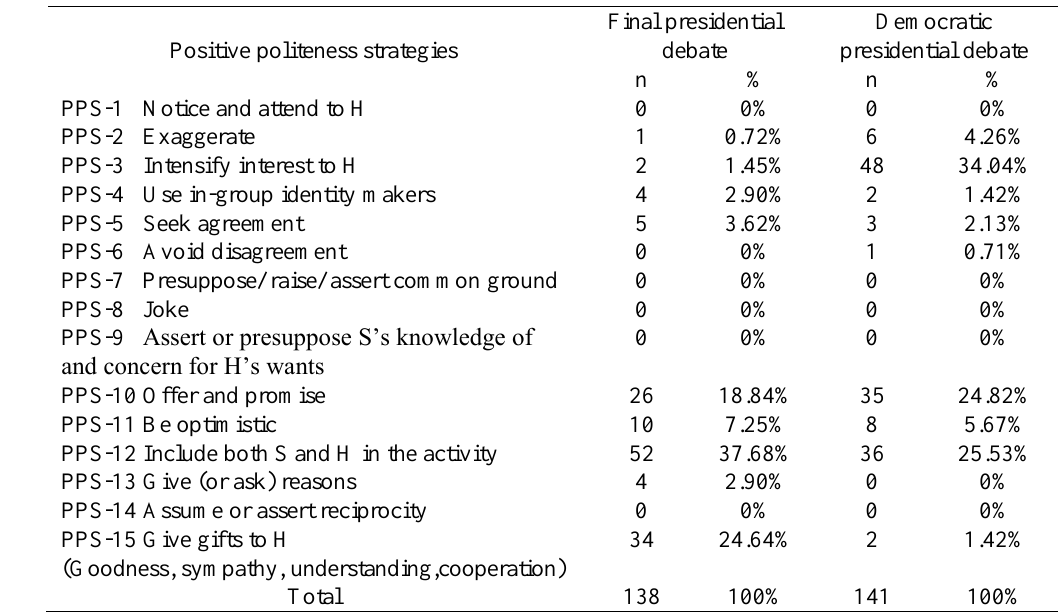
TABLE 3 | Distribution of positive politeness strategies in the two debates Positive politeness